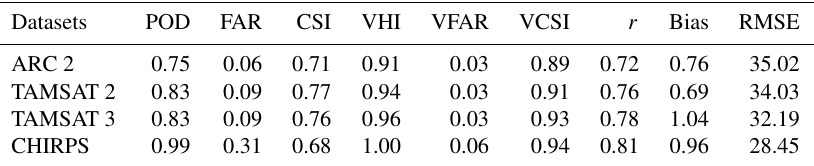
Figure 2. Comparison of mean satellite rainfall estimates for (a) Kiremt season (June–September) and (b) annual rainfall over the Upper Blue Nile basin for the period of 2000–2015. Years with missed values were not considered in the mean analysis. Table 1. Summary of the point-to-grid evaluation at dekadal temporal scale using categorical, volumetric, and continuous statistical tools. Probability of detection (POD), false alarm ratio (FAR), critical success index (CSI), volumetric hit index (VHI), volumetric false alarm ratio (VFAR), volumetric critical success index (VCSI), correlation coefficient ( r ), bias, and the root mean square error (RMSE). The RMSE values are shown in